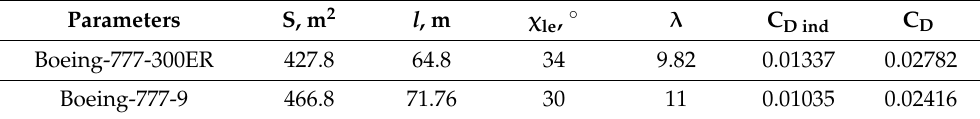
Table 1. Dependence of changes in C D ind on wing aspect ratio for Boeing 777 aircraft family.